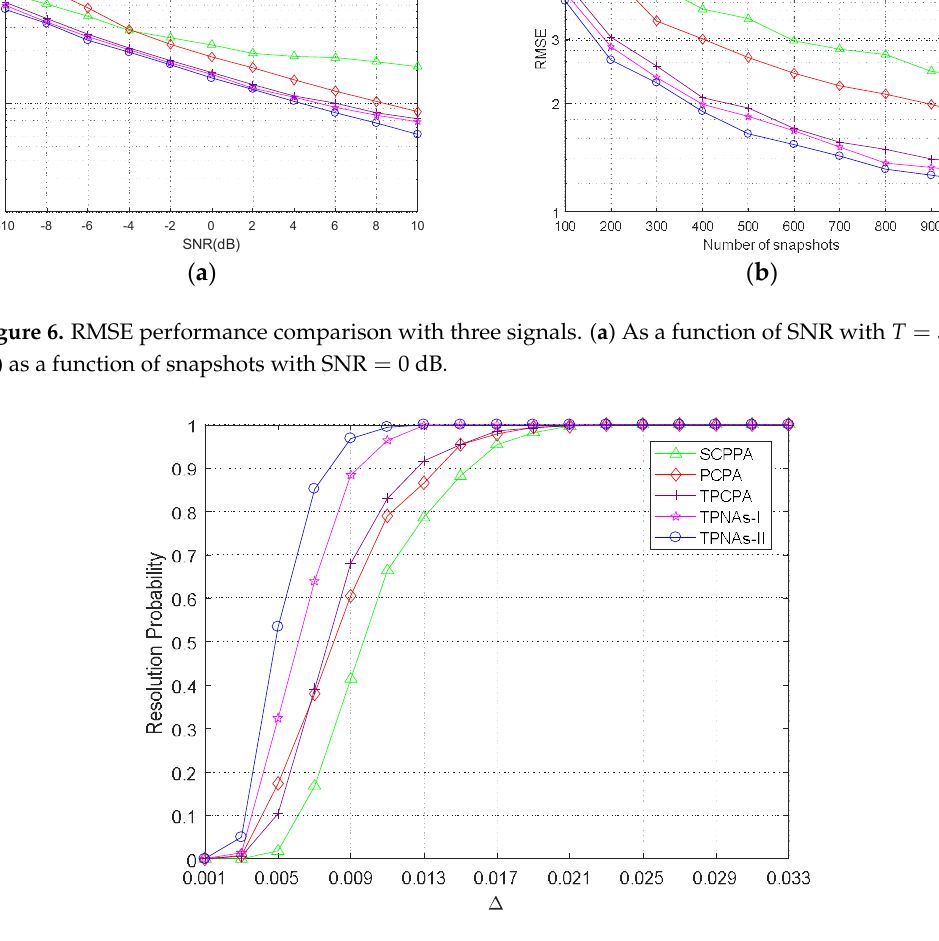
Figure 7. Resolution probability versus Δ , where (cid:1846) = 500 and SNR = 0 dB .